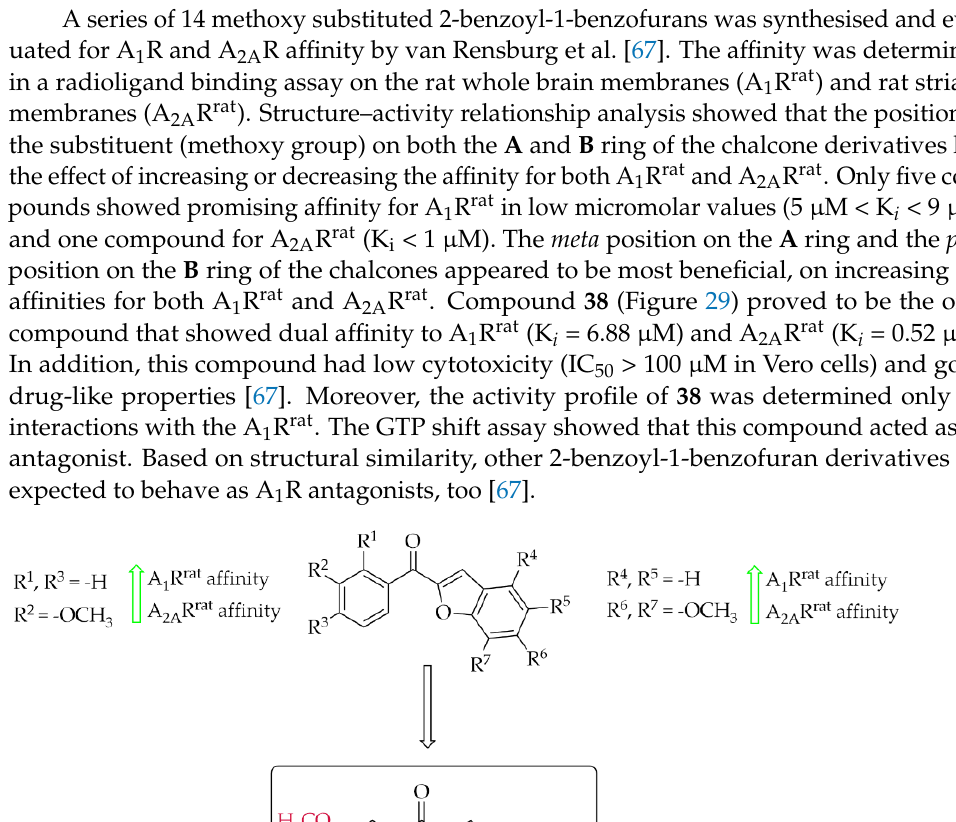
Figure 28. Aniline-based chalcones and the most active compound in the series [66].